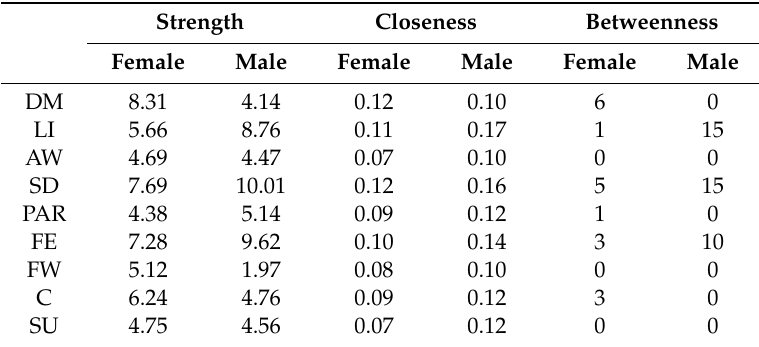
Table 3. Centrality measures for CIDI65 + items by gender groups.